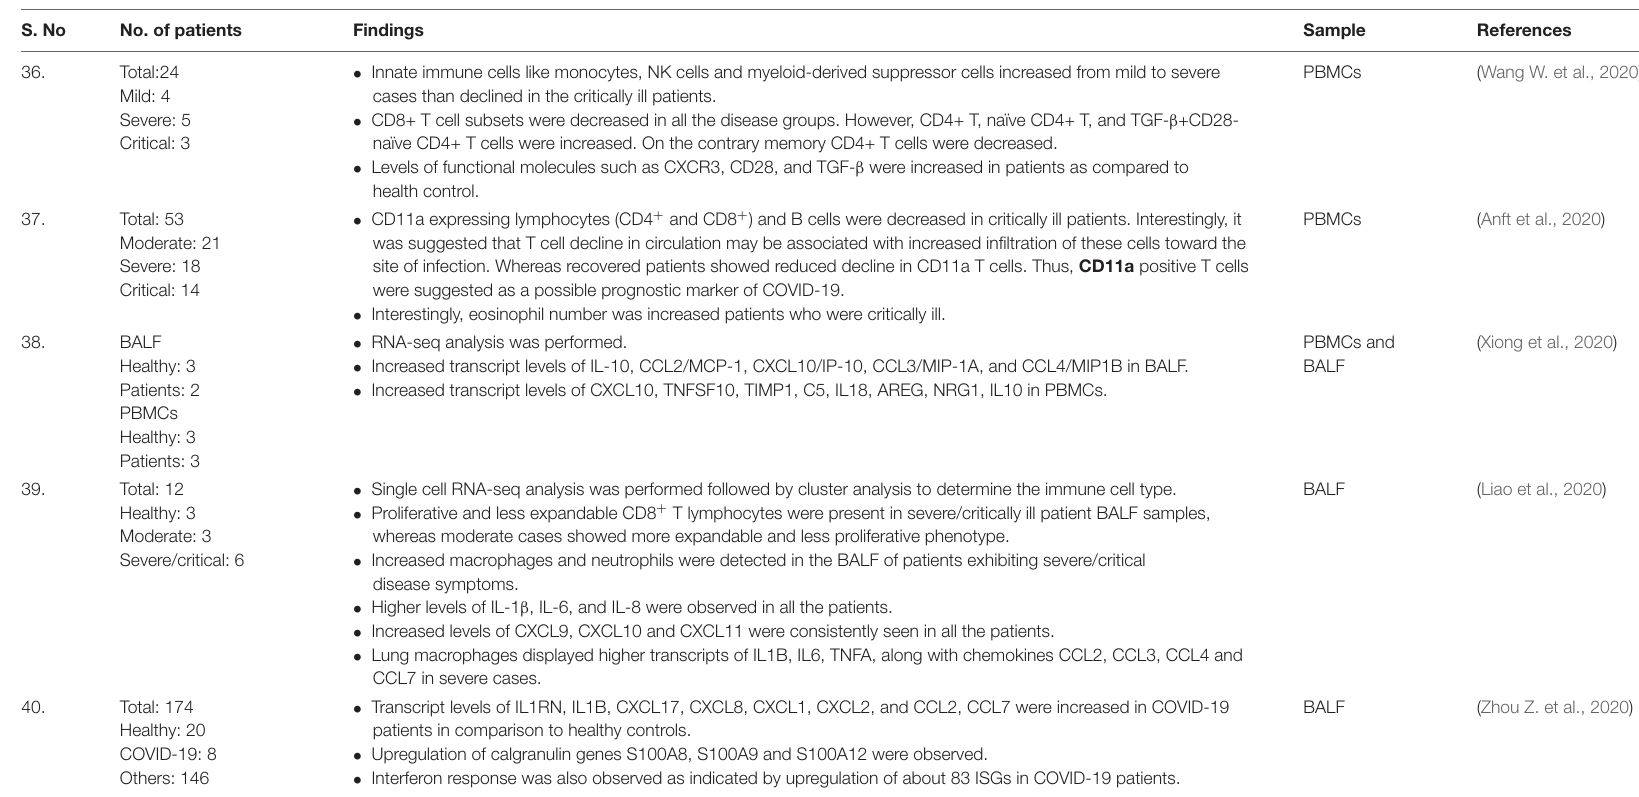
The highlighted studies show the respective predictive biomarkers (in bold) which were found in the